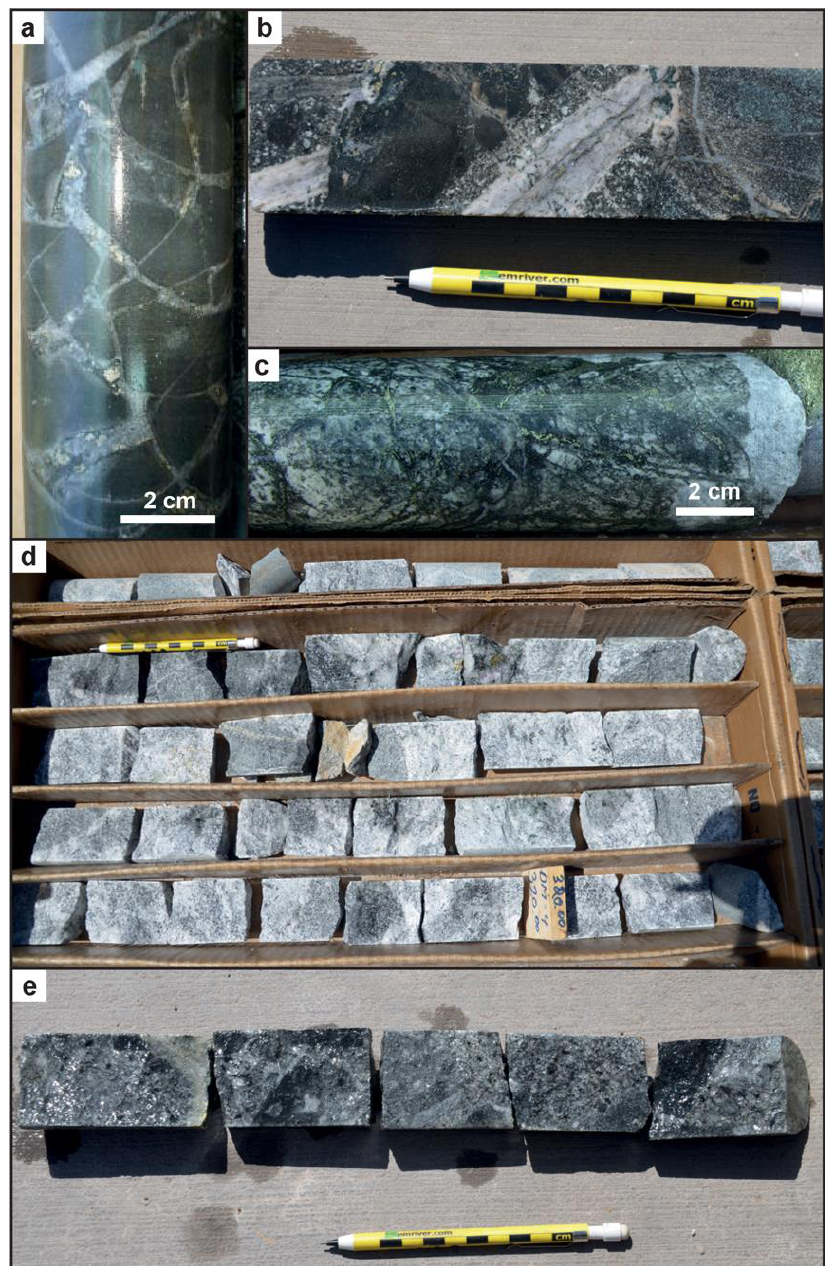
Figure 7. Breccia lithologies recognized in the Don Manuel system: hydrothermally cemented hornfels/calc-silicate breccia, polymict breccia, and igneous breccia. ( a ) Quartz-anhydrite-ce- mented hornfels breccia, DM6, 410 m. ( b ) Polymict breccia with clasts of IPD, mudstone hornfels and